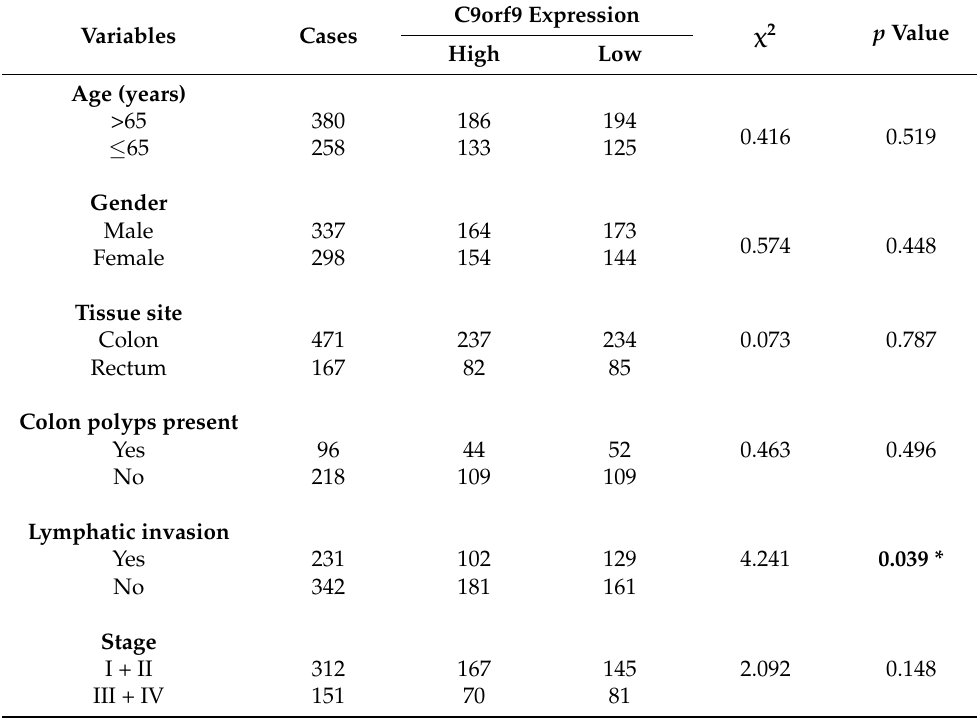
Table 2. Correlation of C9orf9 expression to clinical variables of TCGA CRC